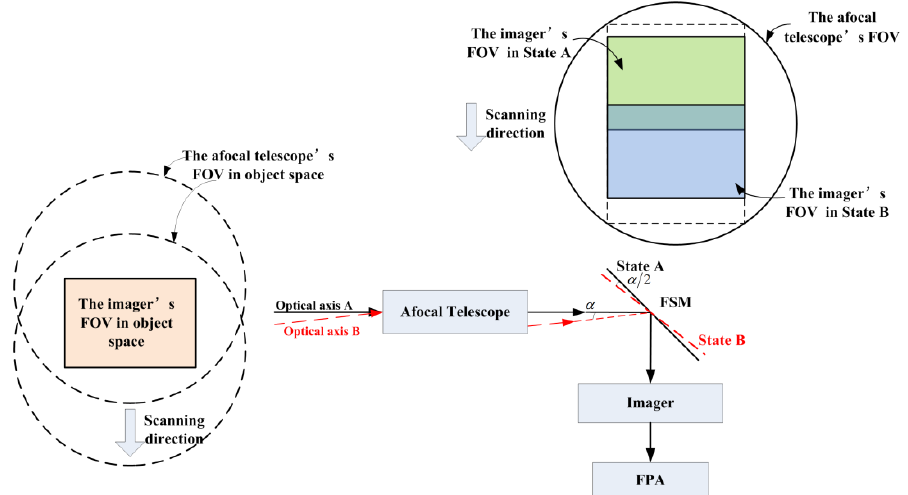
Figure 4. Schematic diagram of an imaging system. The imaging system includes a front-end afocal telescope, a fast steering mirror (FSM), an imager and a focal plane array (FPA). Assuming that the angular magnification of the afocal telescope is the imager is